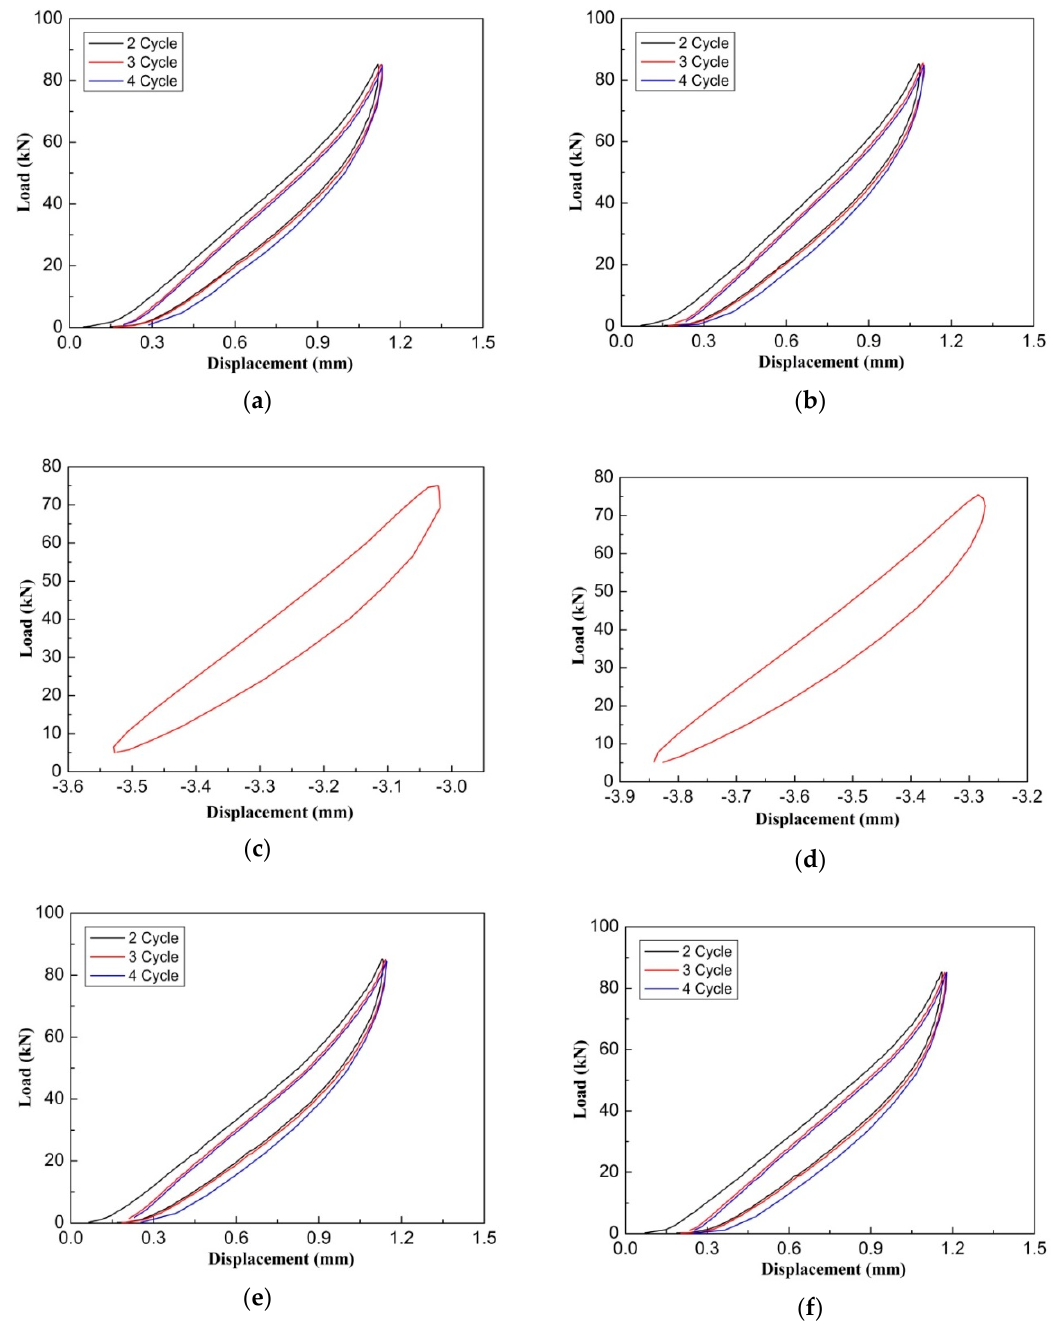
Figure 18. Load–displacement curves. ( a ) Static test (new rail pad); ( b ) static test (used rail pad); ( c ) dynamic test (new rail pad); ( d ) dynamic test (used rail pad); ( e ) static test after aging tests (new rail pad); and ( f ) static test after aging tests (used rail pad). Table 5. Rail pad spring stiffness test results.